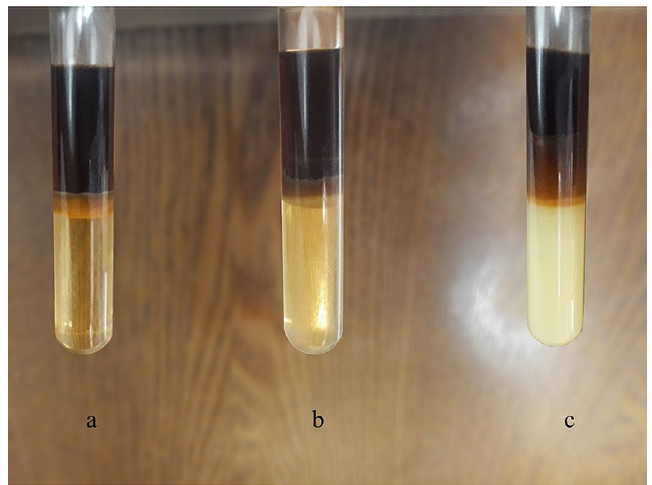
Figure 1. Phase separation results for the synthetic microemulsion system ( S µ E ) formed with a) Mixtures (1), b) Mixture (2), and c) Mixture (3).